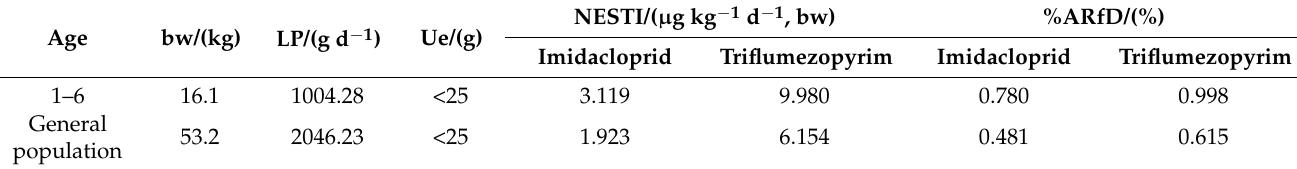
Table 5. Short-term intake assessment of triflumezopyrim and imidacloprid.